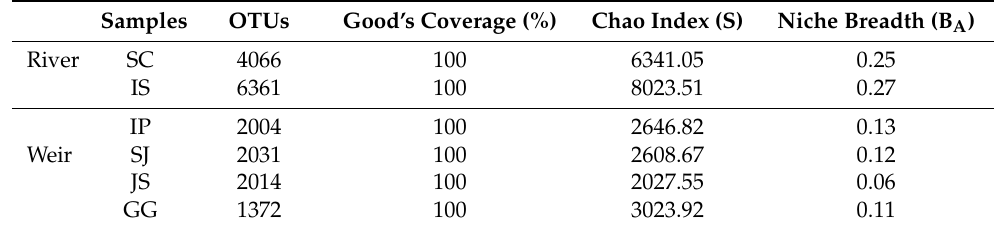
Table 2. Operational taxonomic units (OTUs), Good’s coverage, Chao1 (S), and niche breadth (B A ) estimated for the diet composition of